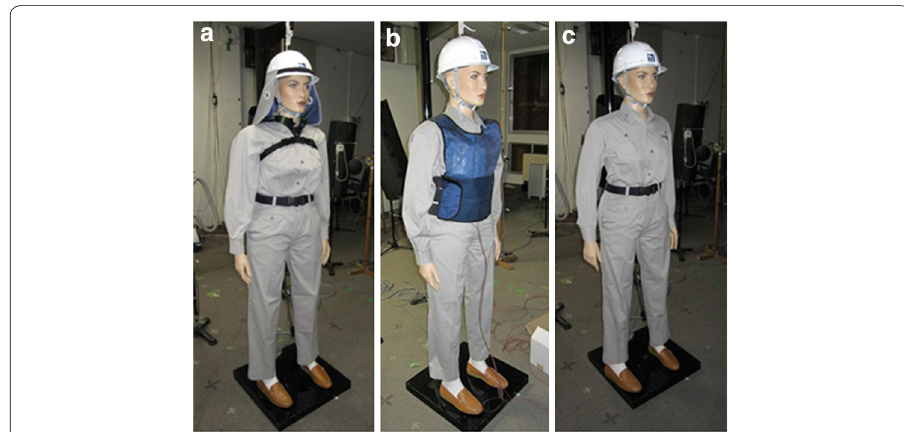
Fig. 1 Device setting for measurement. a FANS, b VEST, c REF